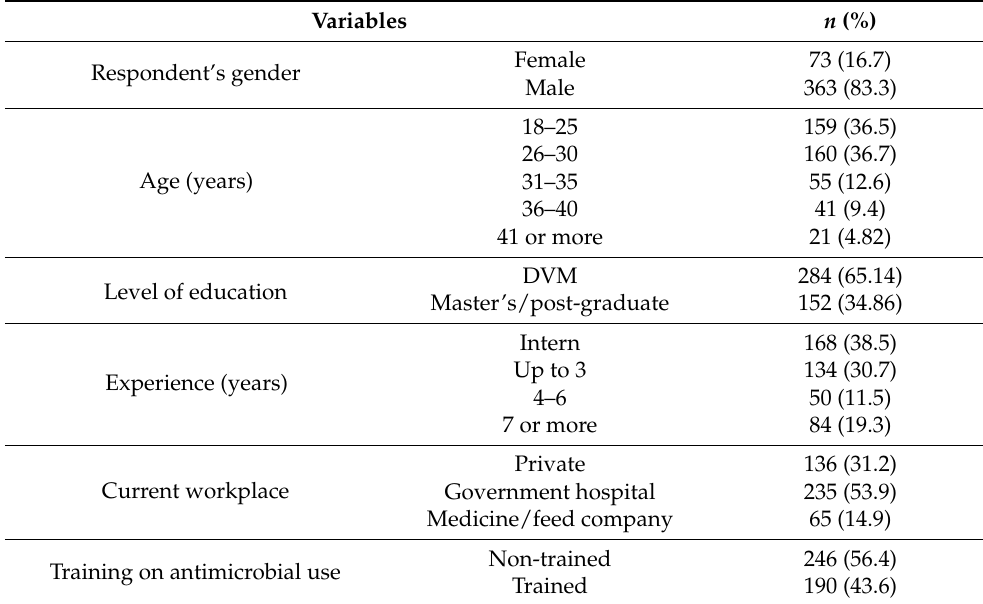
Table 1. Demographic characteristics of study participants.